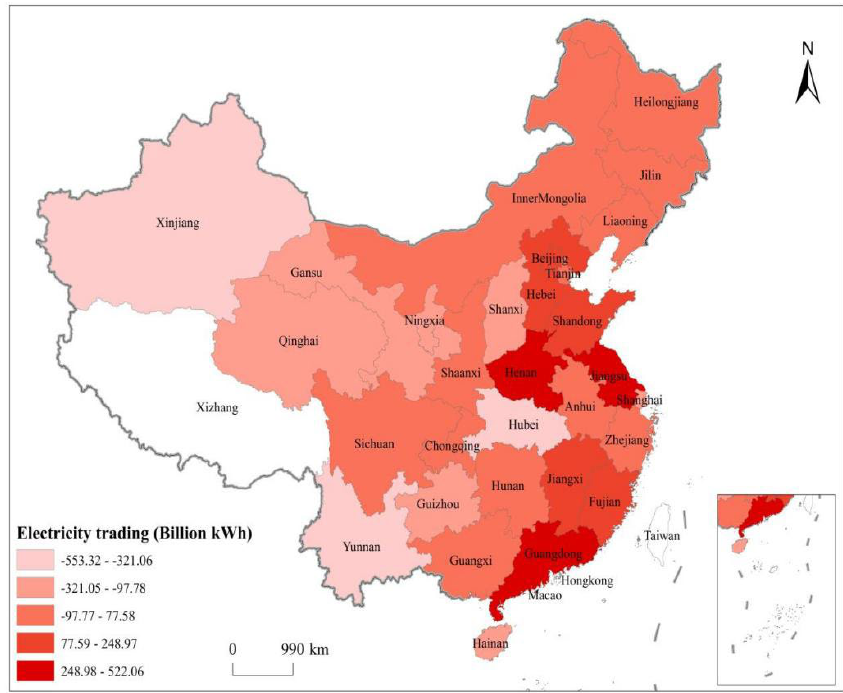
Figure 7. Electricity trading by province.